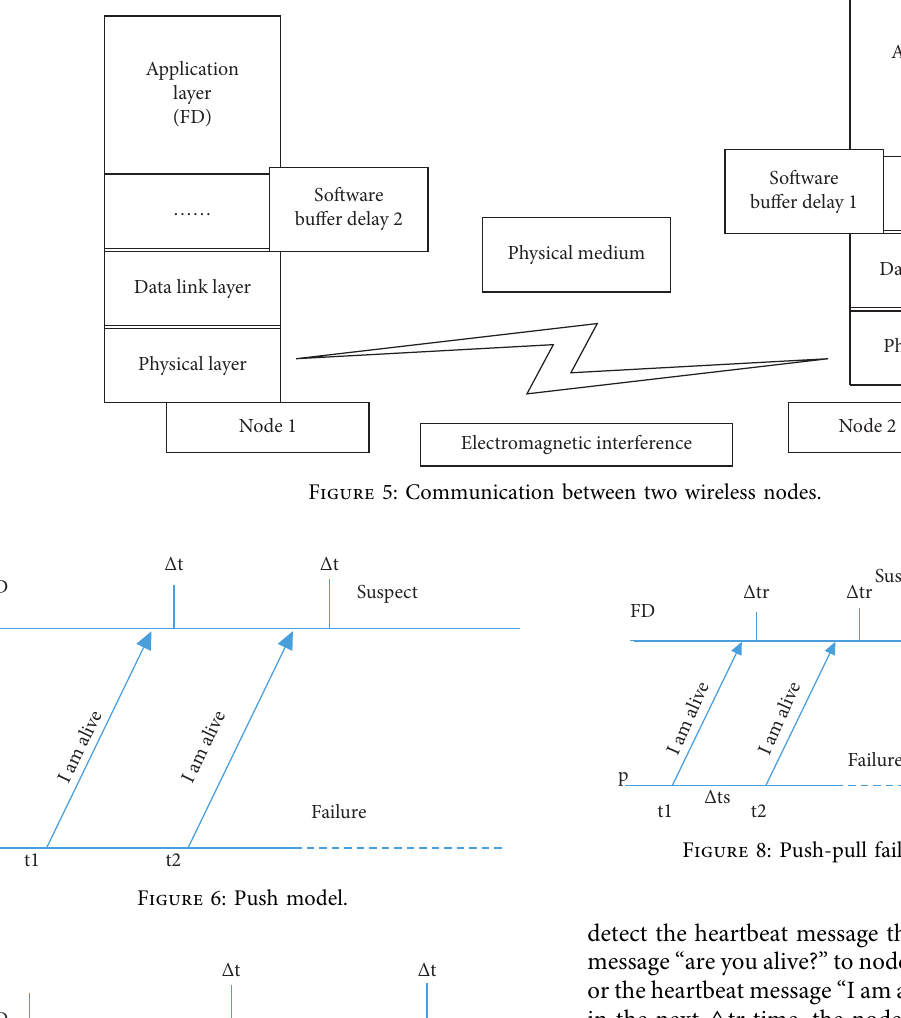
Figure 6: Push model.